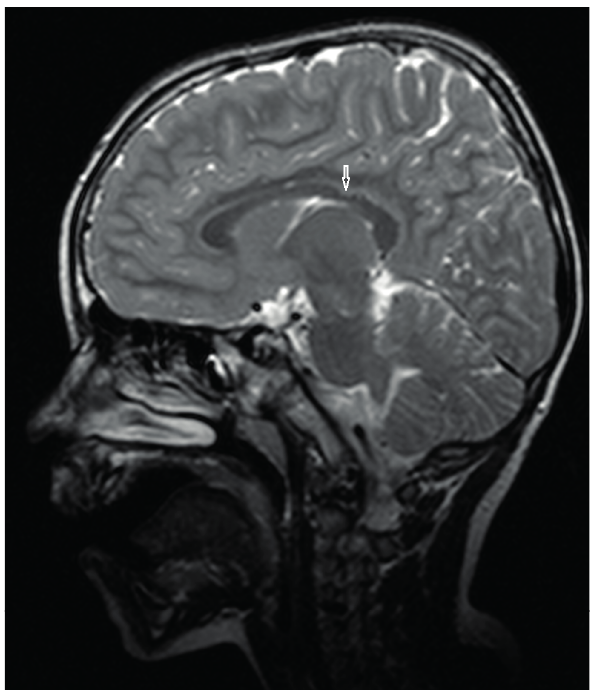
Fig. 1. Focal hypoplasia in the posterior body of the corpus cal- losum, 5-year-old autistic boy, MRI T2/TSE in the sagittal plane.